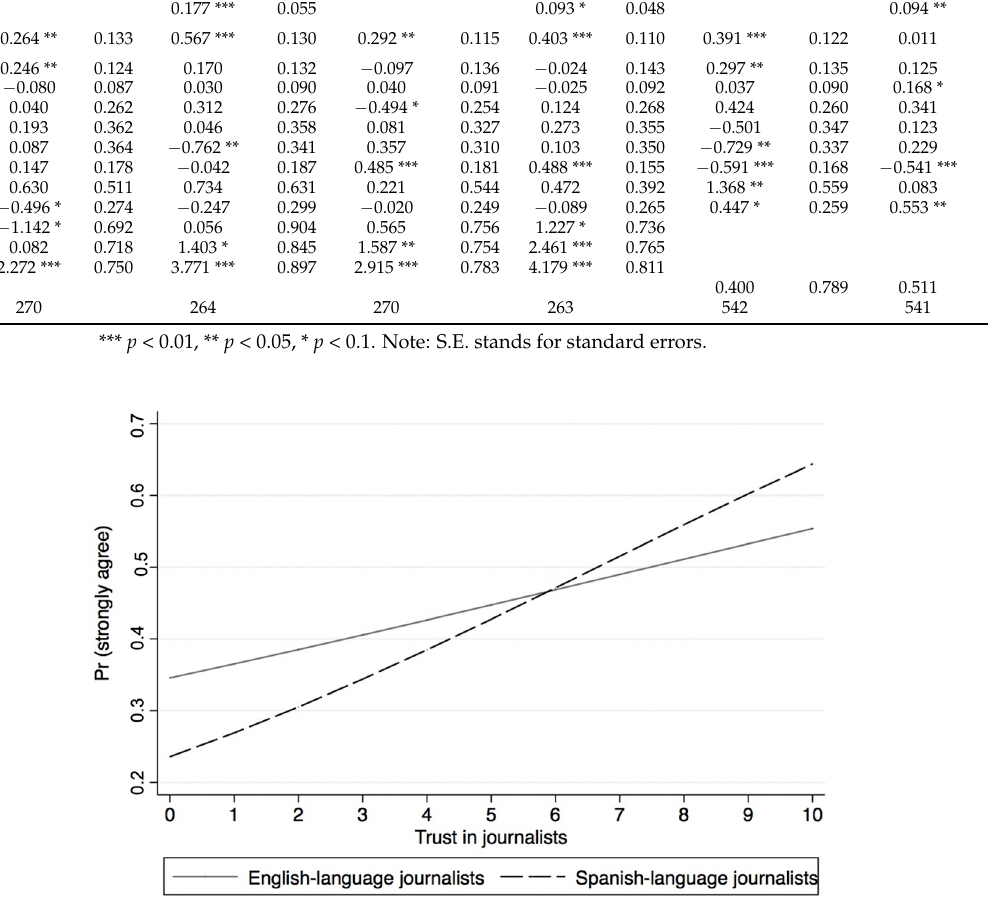
Figure 2. Predicted probabilities of reporting “strongly agree” on state and local officials providing clear information about what to do to stop the spread of COVID-19.